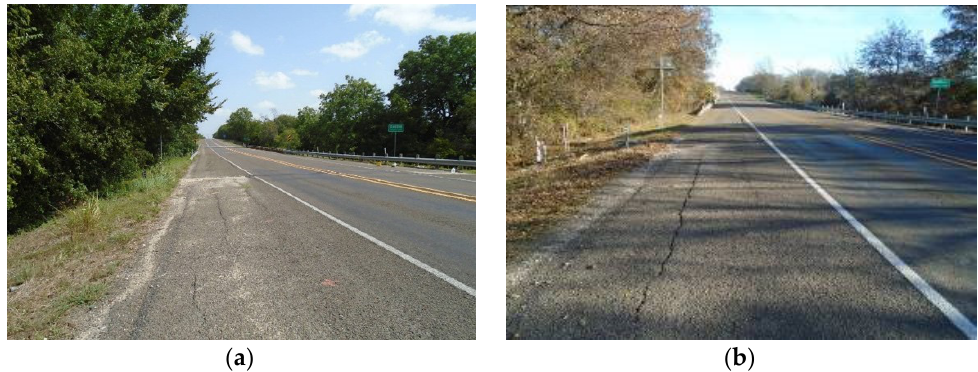
Figure 6. Comparison of roadside trees at SH 342 site in ( a ) summer and ( b ) winter.